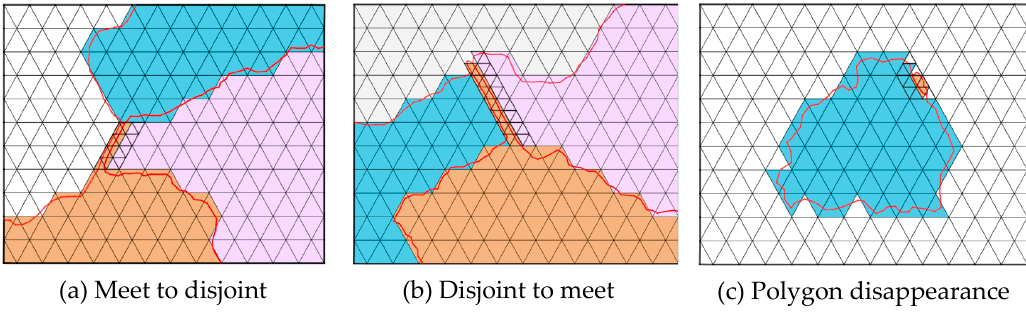
Figure 12. Four topological distortion repair examples.